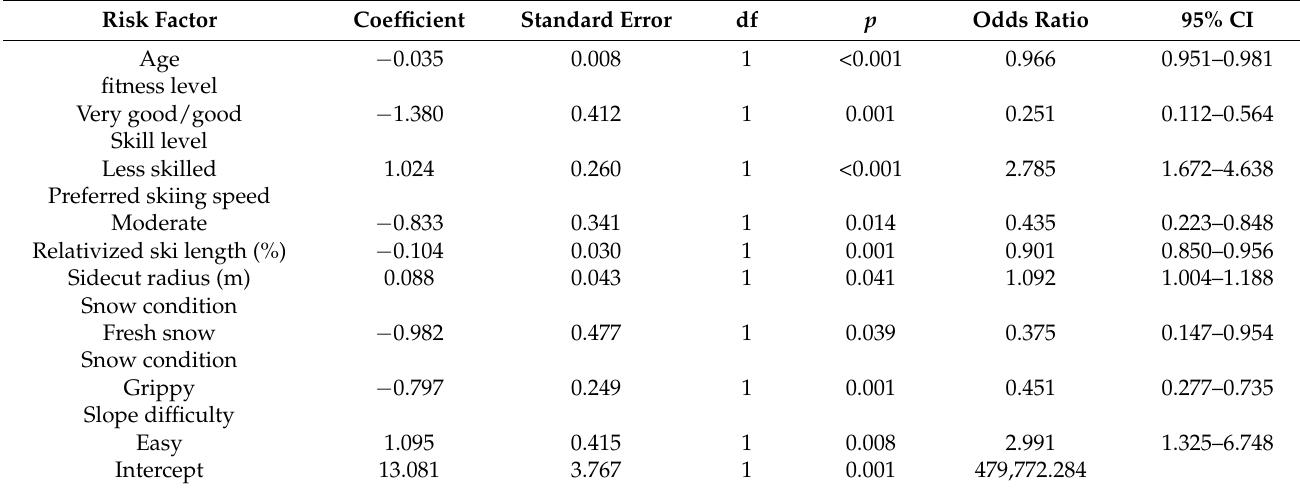
Table 2. Significant results of adjusted odds ratios of individual, equipment-related and environmental factors associated with risk of